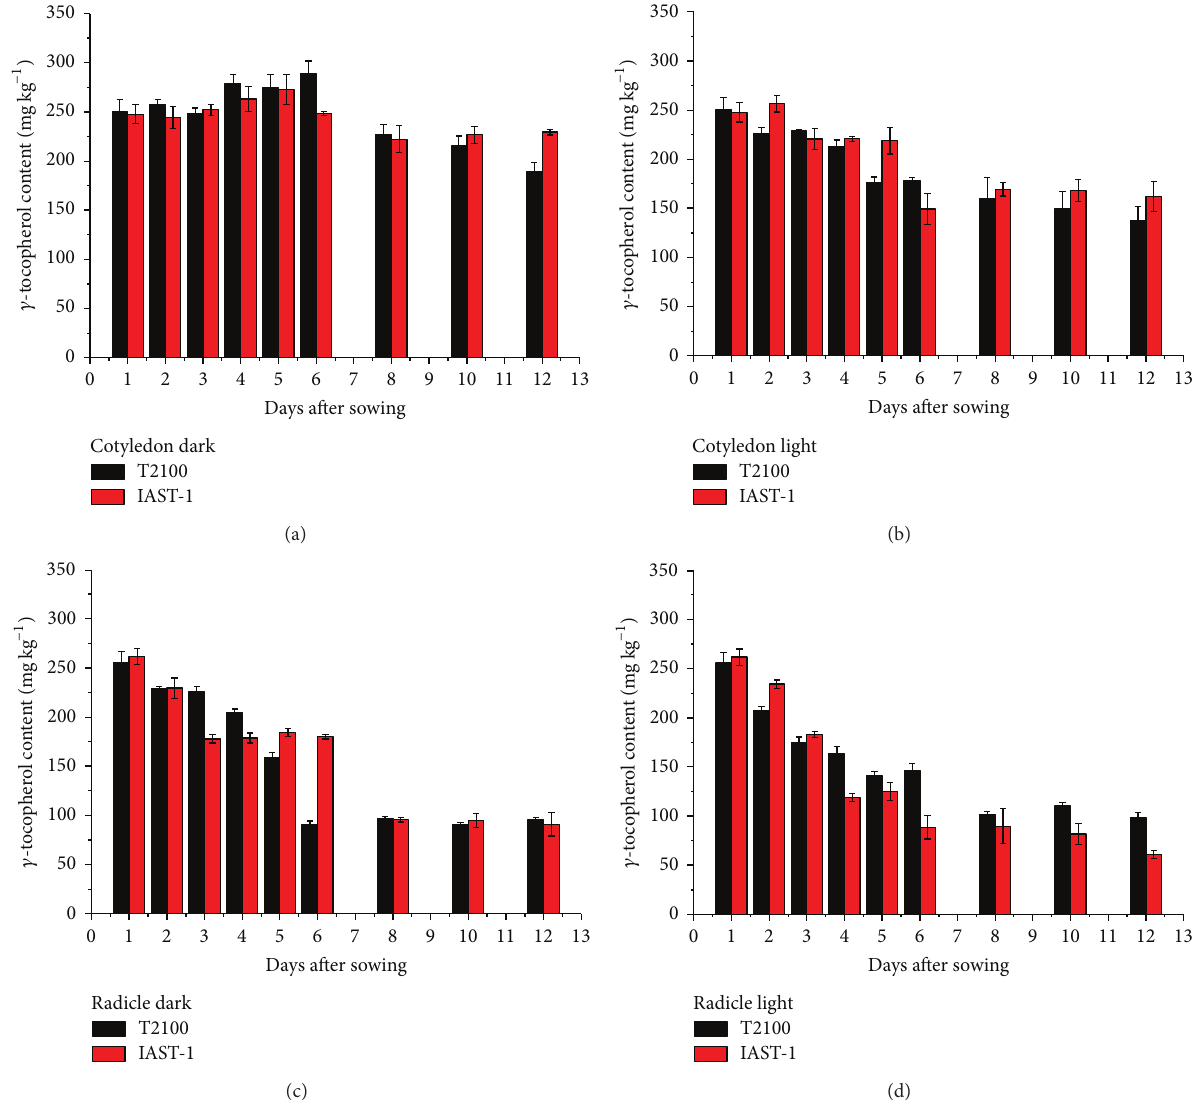
Figure 5: 𝛾 -tocopherol content (mgkg −1 dry tissue) from 1 to 12 days after sowing in cotyledons and radicles of sunflower lines T2100 and IAST-1, with seed tocopherol content predominantly in the 𝛾 -tocopherol form, from seedlings grown under dark and light conditions. Data are presented as mean ± standard error of three